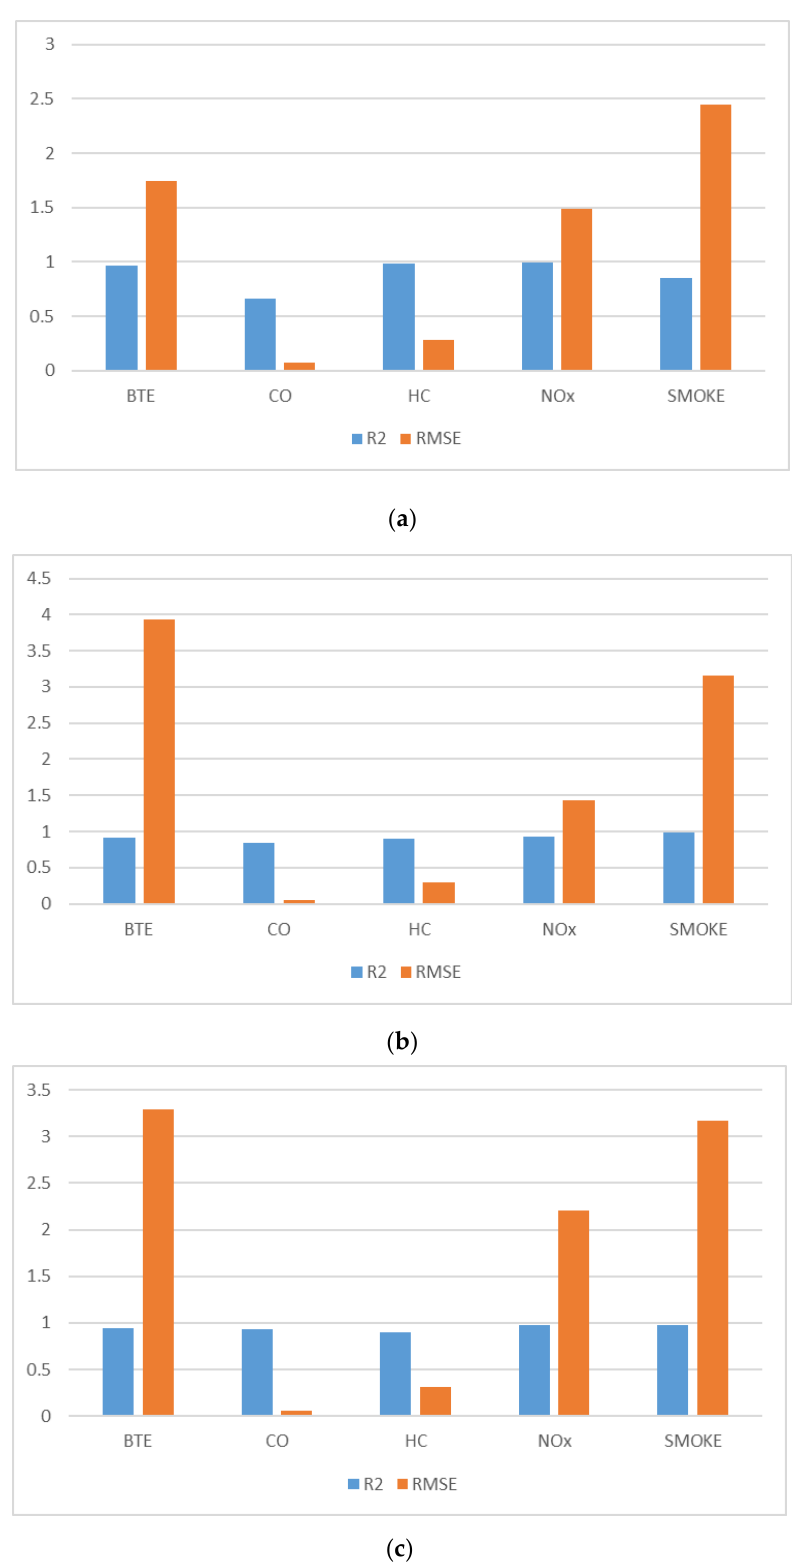
Figure 5. Illustration of R 2 and RMSE of the model for ( a ) 3 neurons; ( b ) 5 neurons; and ( c ) 7 neurons.